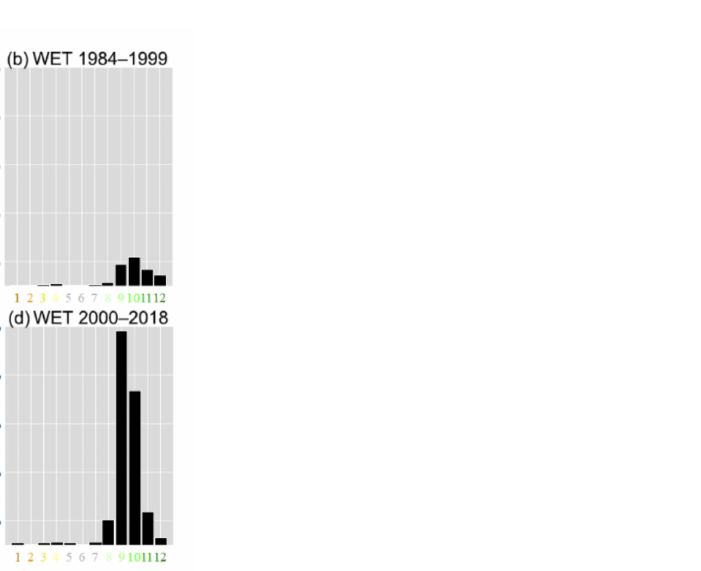
Figure 6. NDVI trend for the EET and WET in the periods of 1984–1999 and 2000–2018. ( a ) NDVI trend over EET in 1984–1999; ( b ) NDVI trend over WET in 1984–1999; ( c ) NDVI trend over EET in 2000–2018; ( d ) NDVI trend over WET in 2000–2018. The color of the labels below the horizontal axis matches the legend in Figure 4.